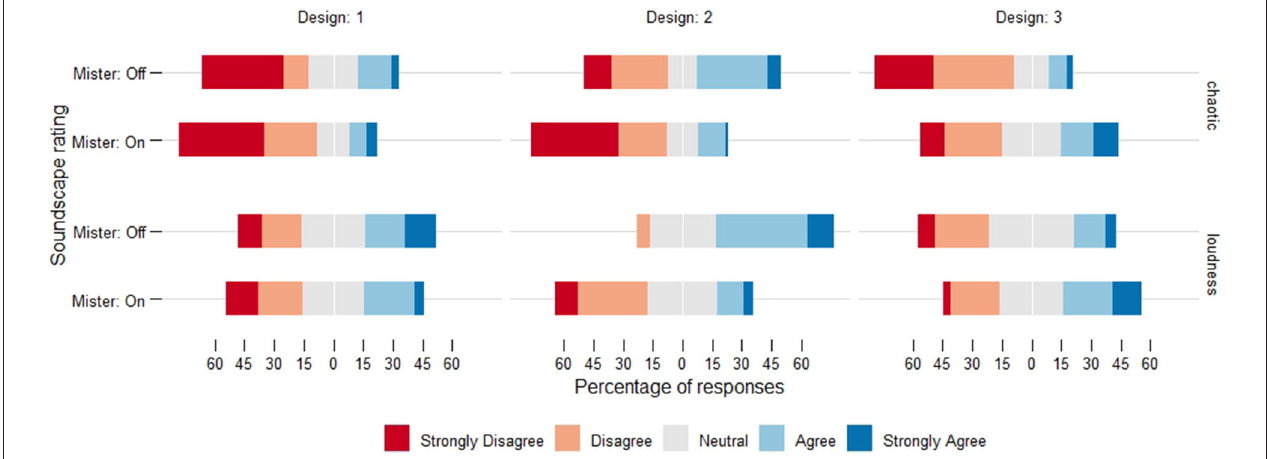
FIGURE 4 | Distribution of the Likert-scale responses for chaotic and loudness only. Each subplot represents a single condition (design and status of the